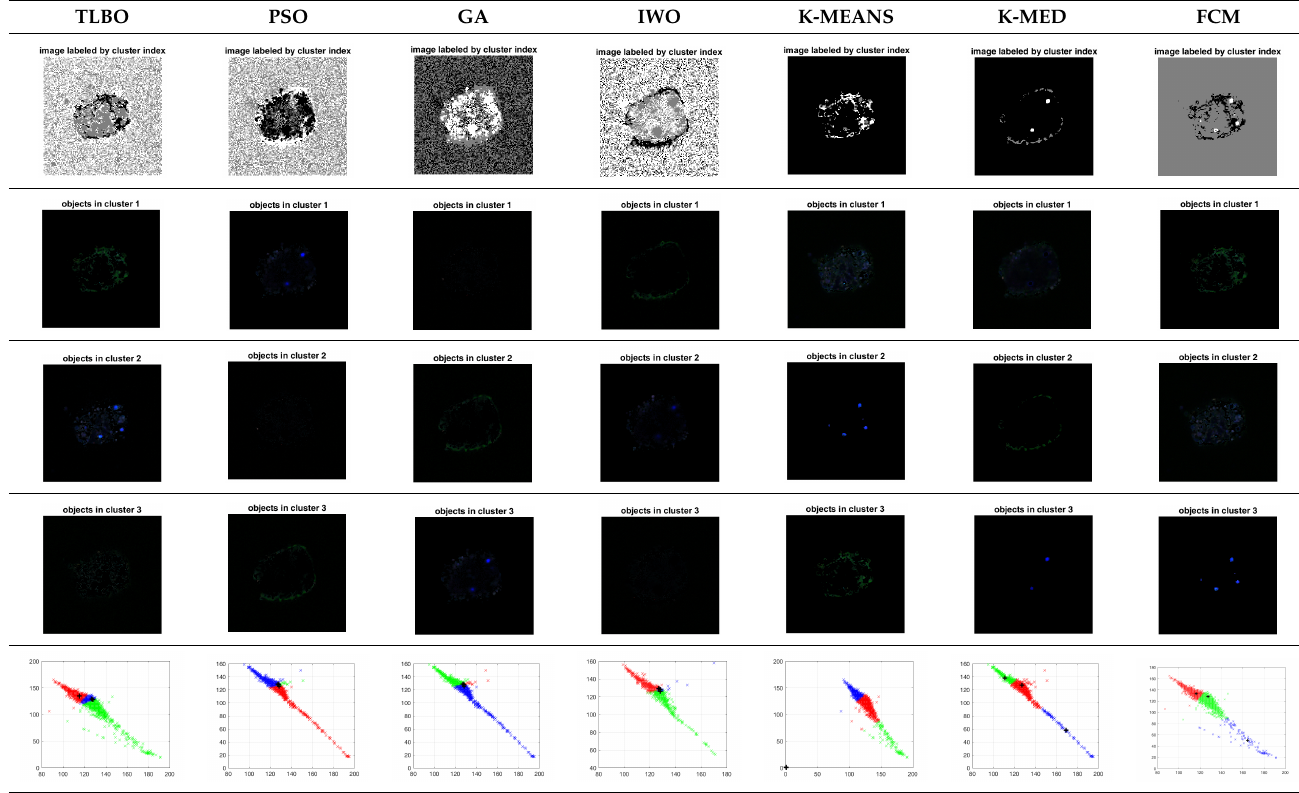
Table 2. Comparative analysis of visual TLBO results with other clustering algorithms for 2:0.5 ratio image of Figure 1a.